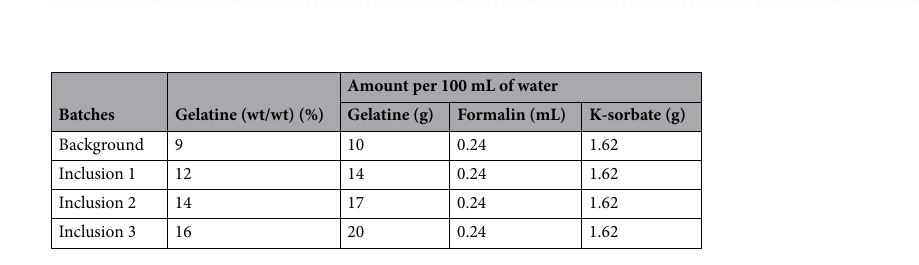
Table 3. Gelatine concentration and amount of each component for different phantom